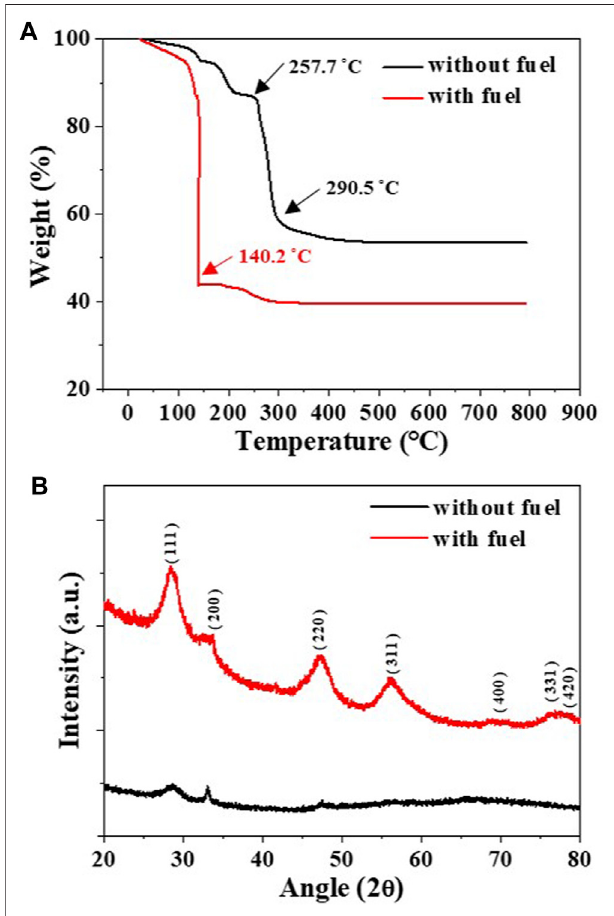
FIGURE 2 | (A) TGA of the dried gels of GDC precursor solutions with and without fuel and (B) the XRD patterns of GDC powders after TGA measurement up to 600 °